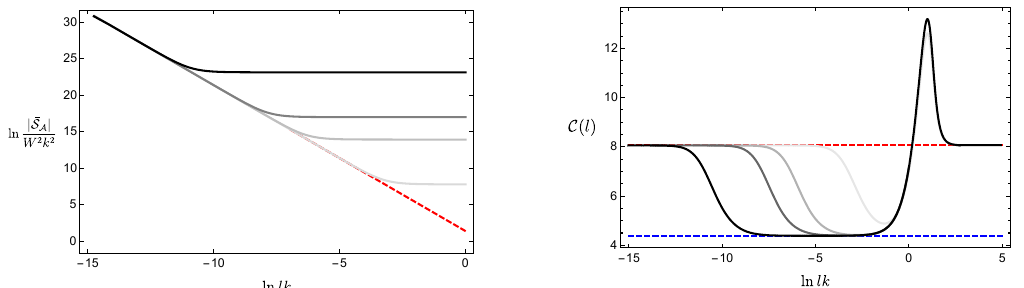
Figure 5 . The size of the entanglement entropy j (cid:22) S A j (left) and the entropic c -function C ( l ) (right) evaluated for the boomerang RG (cid:13)ows for (cid:0) =k 3 = 2 = 10 2 (lightest), 10 4 ; 10 5 and 10 7 (darkest), as in (cid:12)gure 3. In the left plot, the pure AdS 0 result is a dashed red line. In the right plot, the pure 5 AdS 0 and AdS c results are given by the red and blue dashed lines, 5 5